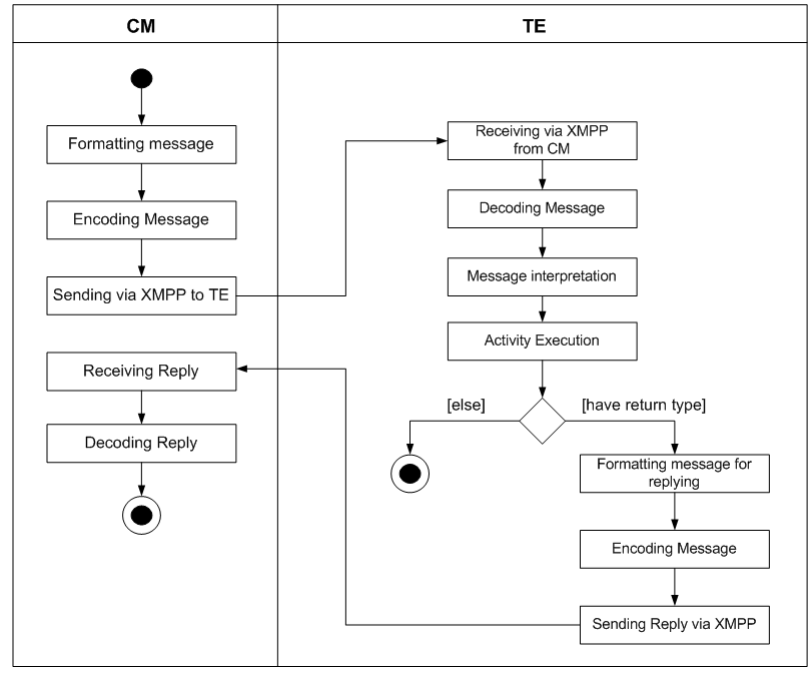
Figure 6. Secure Inter-module communication.